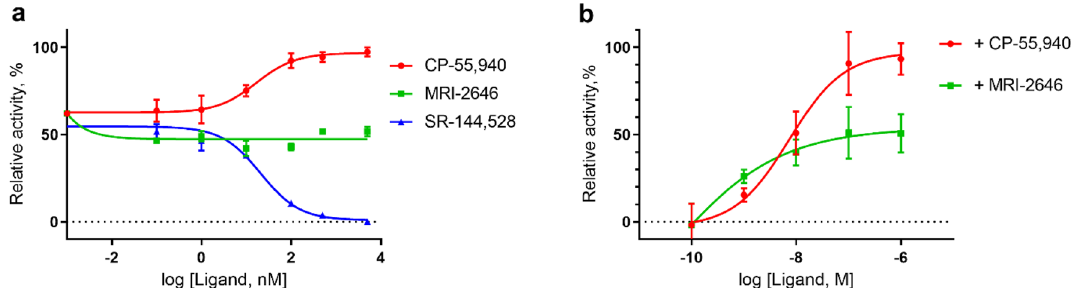
Figure 6. Effect of treatment with MβCD/Chol of E. coli membranes on activation of CB 2 by synthetic ligands. ( a ) Membranes expressing CB 2 were treated with 20 mM MβCD/Chol for 1 h at 4 °C, washed with PBS, and the activation of CB 2 in the presence of ligands determined by GEF; ( b ) control, untreated E. coli membranes expressing CB